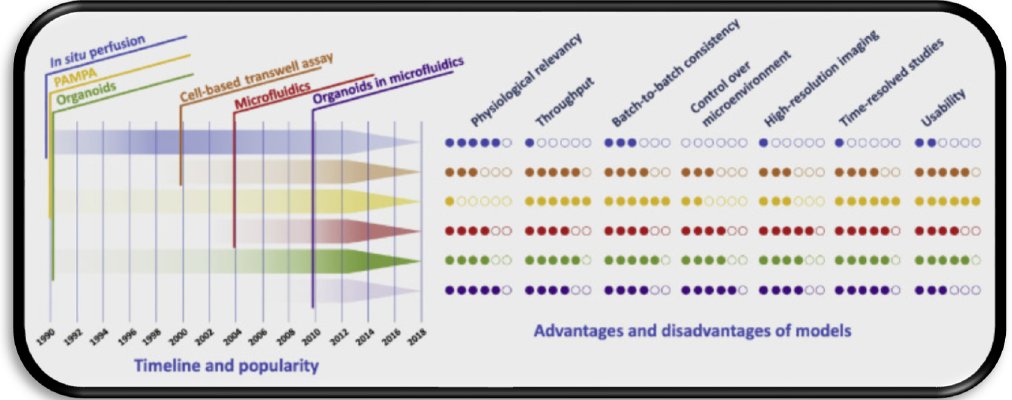
Figure 2. Trends in BBB models 1991–2018. The opacity of the lines in the graphic on left refer to overall popularity, and the shaded boxes on the right represent a qualitative 1–6 score where lower scores imply limitations and higher scores indicate relative strengths of a particular model. PAMPA = parallel artificial membrane permeability assay, a cell free assay used to screen the permeability of compounds based on the pass from a donor to acceptor compartment separated by an artificial lipid membrane. Reproduced with permission from Oddo and colleagues, Trends in biotechnology; published by Cell Press 2019 [54] based on data in Mahto and colleagues [64].